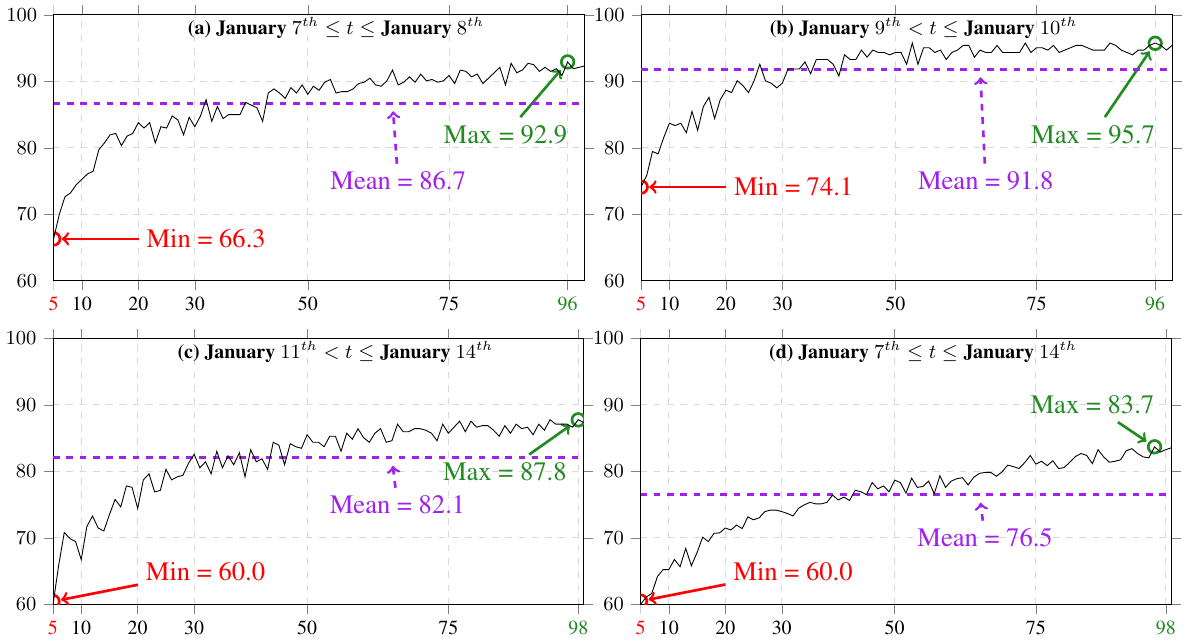
Figure 3: Country classification accuracies (%) using various author topic-based representations on the test sets with different epochs. X-axis represents the number n of classes contained into the topic space ( 5 ≤ n ≤ 100